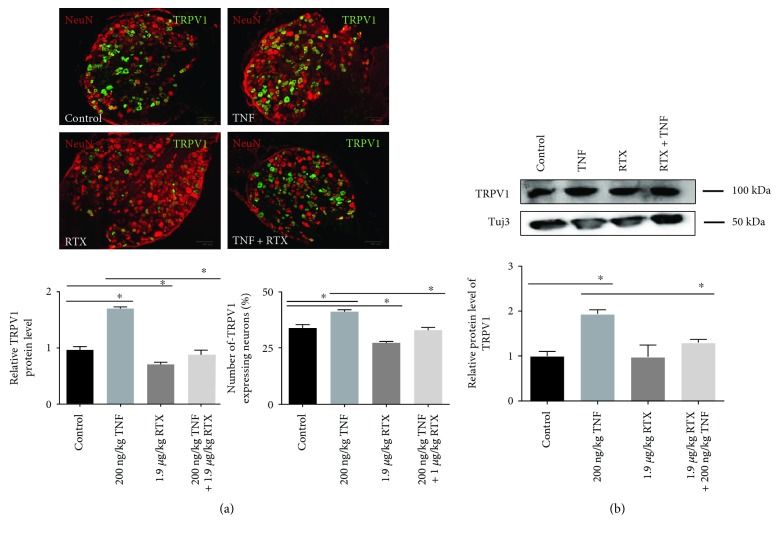
Influence of intrathecal administration of TNF and TNF + RTX on the protein level of TRPV1 and the number of TRPV1-expressing DRG neurons. (a) Immunohistochemical staining of DRG slices 24 h after administration of either 200 ng/kg TNF, 1.9 μg/kg RTX, or 200 ng/kg TNF + 1.9 μg/kg RTX. DRG neurons were stained against NeuN (red), as a neuronal marker and TRPV1 (green). Quantification of TRPV1-derived signals revealed significant increase in TRPV1 protein level after TNF administration, (p < 0.001), while administration RTX decreased the TRPV1 protein level significantly (p < 0.001), compared to control conditions. When TNF and TRPV1 were administrated together, a significant change to sole TNF administration was observed. Combined administration of TNF and RTX abolished the TNF-mediated increase of the TRPV1 protein level (p < 0.001). No significant change was observed when compared to untreated control (∗p > 0.05). In addition to the protein level of TRPV1, the number of TRPV1-expressing neurons within the DRG was significantly increased after TNF administration, compared to control conditions (∗p < 0.05). RTX administration significantly decreased the number of TRPV1-expressing neurons (∗p < 0.05). Combined application of TNF + RTX led to a significant reduction of TRPV1-positive neurons, compared to TNF administration (p < 0.01). When compared to control conditions, no significant alteration in the number of TRPV1-expressing neurons was observed (∗p > 0.05). (b) Western blot analysis showed an increase of TRPV1 protein level 24 h after TNF administration (∗p < 0.05), while additional administration of RTX reduced this effect (∗p < 0.05).